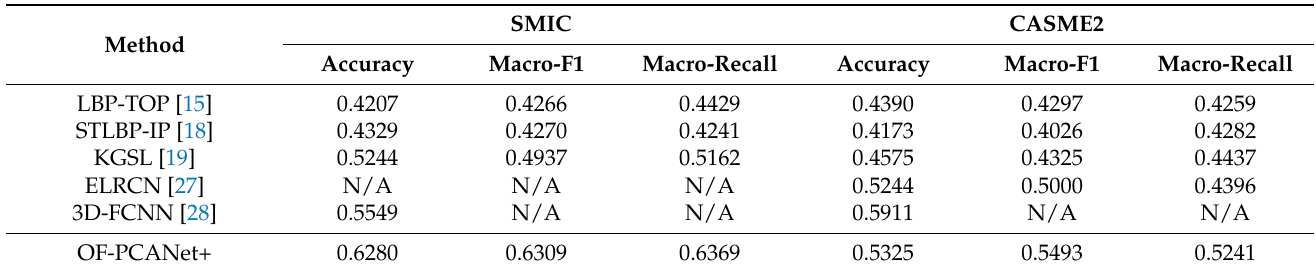
Table 6. Comparisons of different